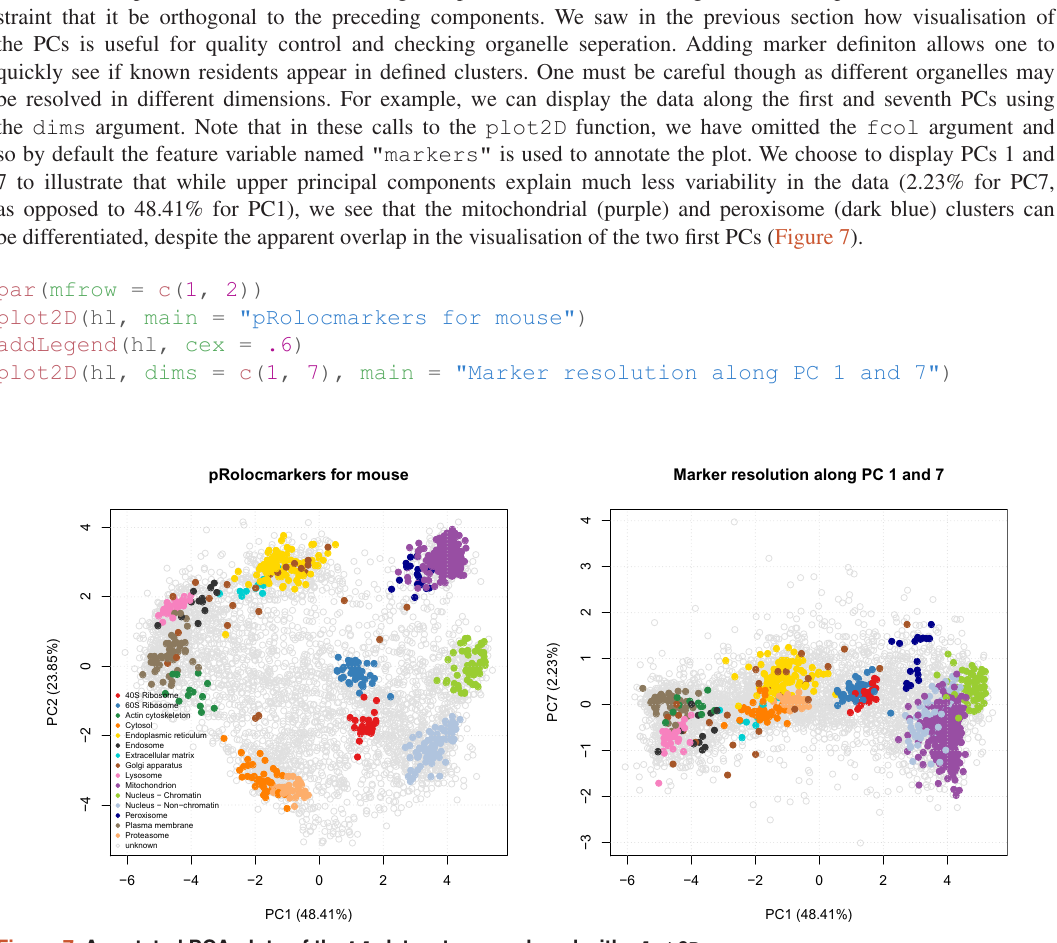
Figure 7. Annotated PCA plots of the hl dataset, as produced with plot2D